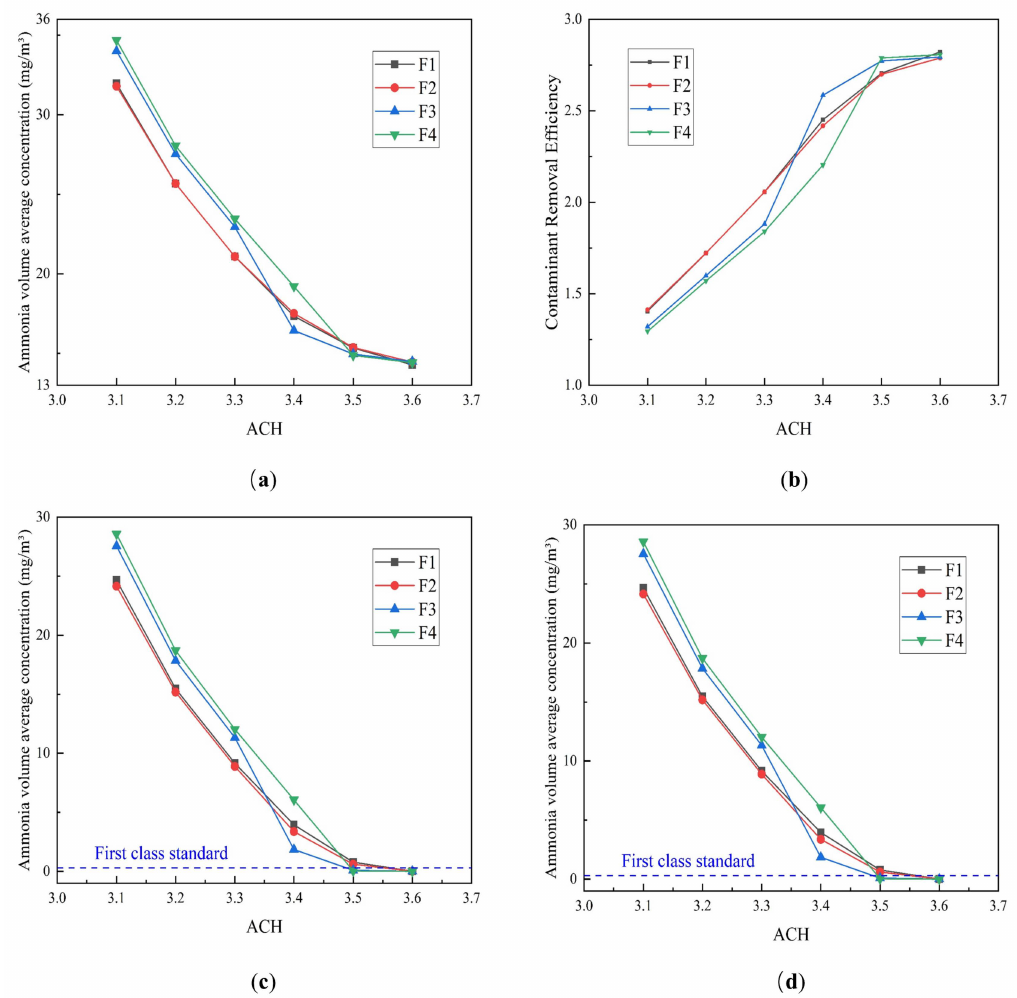
Figure 17. ( a , c ) Average volume concentration and ( b , d ) CRE of ammonia in the B-Z for different ACH (unit: h − 1 ) values. ( a ): VAC, ( b ): CRE; ( c ): Z = 0.9 m, ( d ): Z = 1.5